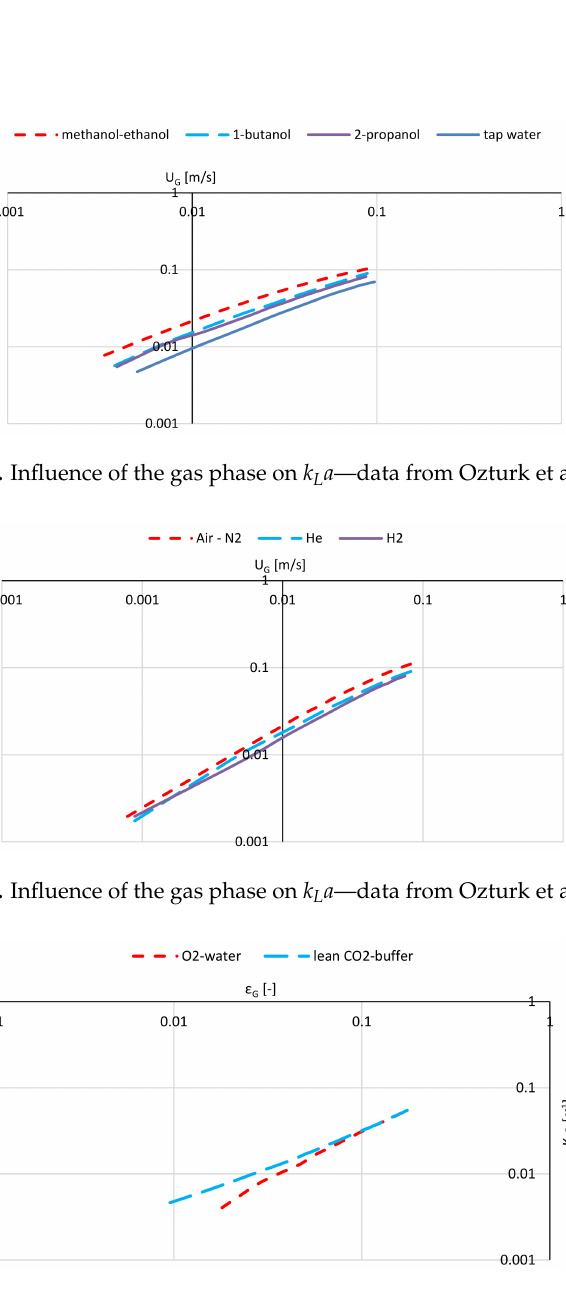
Figure 39. Influence of the gas phase on k L a —data from Gopal and Sharma